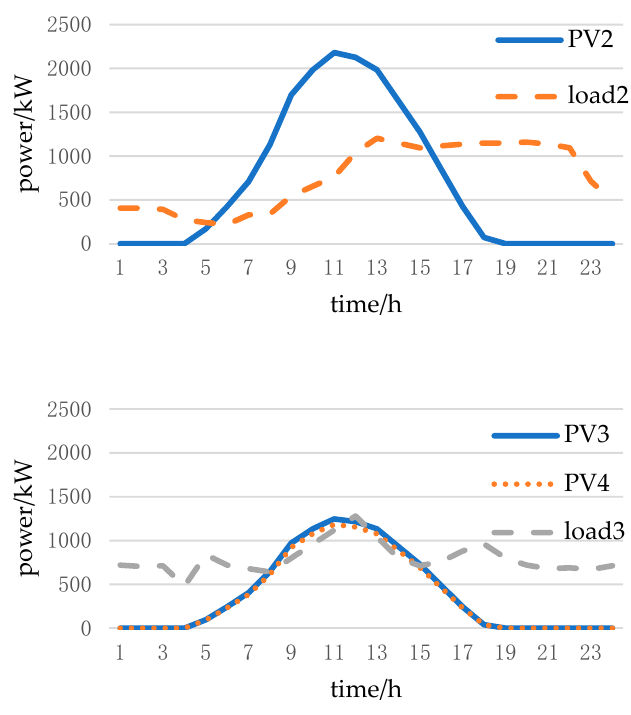
Figure 6. Typical profiles of the loads and the Distributed Generation (DG) output.